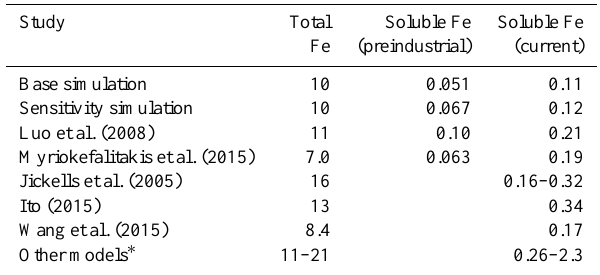
∗ The values are taken from a compilation of literatures (Hajima et al.,